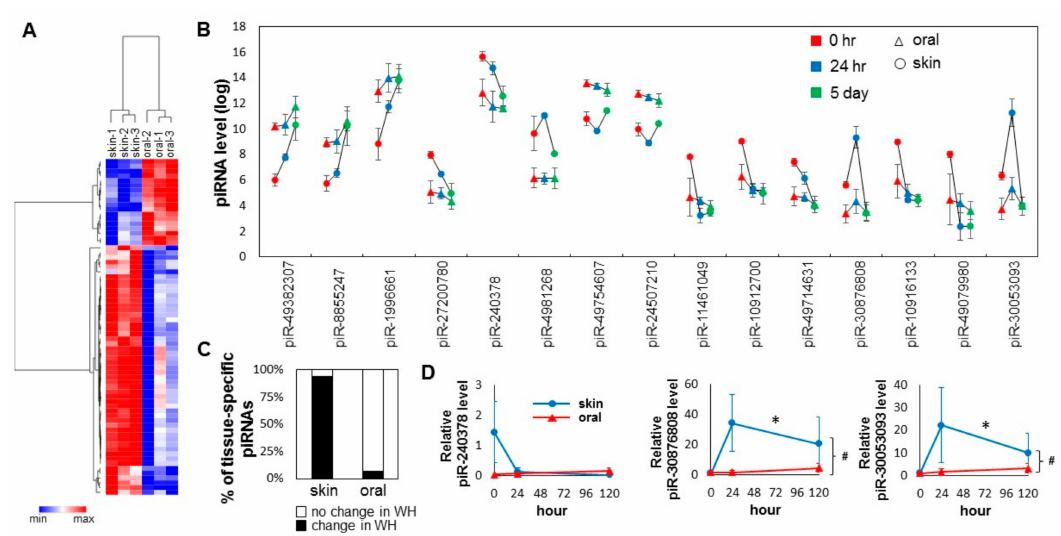
Figure 3. Injury induced changes in the tissue-specific piRNA pattern during skin and oral mucosa wound healing. (A ) Tissue-specific piRNA signatures (presented as heatmap) of the baseline skin and oral mucosa (palate) epithelium were established by their di ff erential expression patterns (70 piRNAs, BH adjusted p < 0.05). ( B ) Changes in the levels of the top 15 tissue-specific piRNAs between the skin and oral mucosa during wound healing time course (* p < 0.05). ( C ) The percentage of those piRNAs that were identified as di ff erentially expressed in normal uninjured tissue that also exhibit expressional changes during skin and oral mucosal wound healing (WH). The di ff erence is statistically significant (chi-square test p = 0.0001). ( D ) The relative levels of piR-mmu-240378, piR-mmu-30876808, and piR-mmu-30053093 were assessed by TaqMan assay-based real-time PCR assays on samples procured from the paired murine skin and oral mucosa (palate) wound healing model (at 0 h, 24 h and 5 days post-wounding, n ≥ 3). * indicates one-way ANOVA test p < 0.05 (within time-course comparison); # indicates two-way ANOVA test p < 0.05 (between time-courses